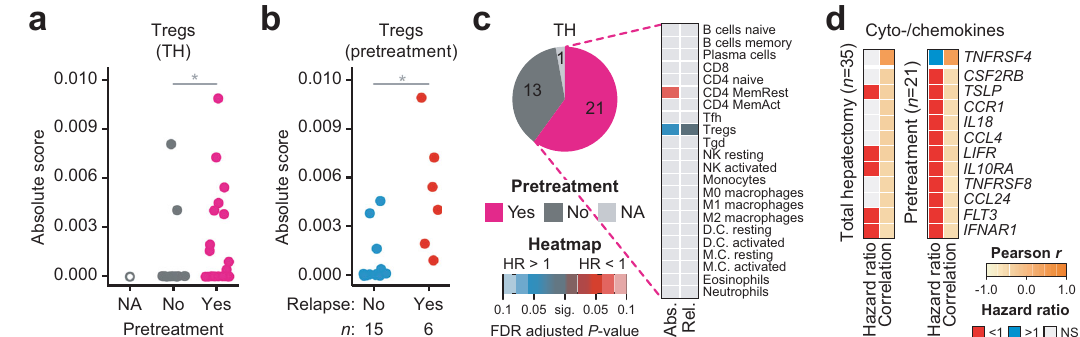
Fig. 6 Association of pretreatment with the in fi ltration of Tregs in the total hepatectomy group. a Absolute score of Tregs upon pretreatment in TH. One-sided Barnard ’ s test, * P < 0.05. b Relapse status and absolute score of Tregs. Welch ’ s t -test, * P < 0.05. c Clinical associations of 22 immune cell types; Abs. absolute score, Rel. relative fraction. Colored boxes adjacent to speci fi c cell types represent the signi fi cance of FDR-adjusted log-rank P values. The heat map is colored in the same manner as that used in Fig. 4c. d Correlations with Tregs and clinical associations of cytokines/chemokine ligands and receptors. The boxes, representing HRs, are colored in blue or red to indicate when relatively high expression was correlated with a poor or good outcome,